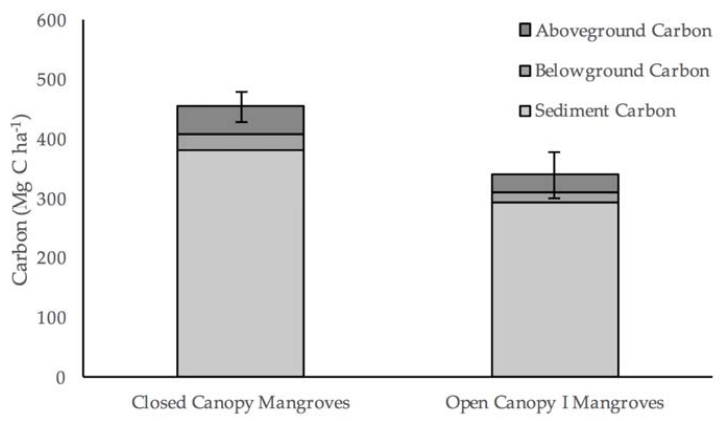
Figure 5. Ecosystem carbon densities of vegetation and soil carbon to 1 m depth in open ‐ and closed ‐ canopy mangroves in Helodrano Fagnemotse. Error bars indicate ±1 standard error of total stocks.